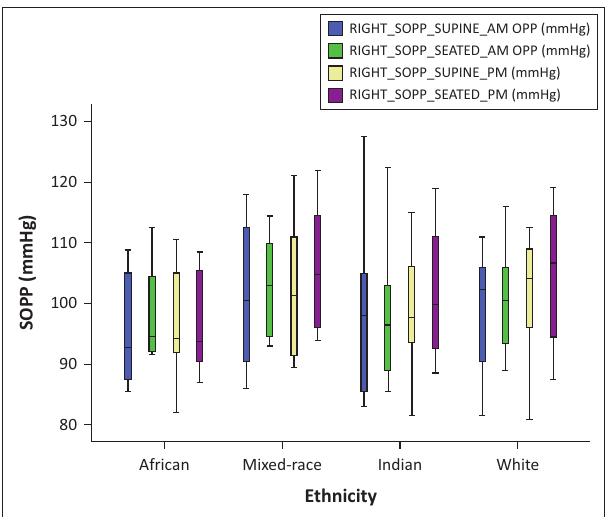
FIGURE 1: Box plot for systolic ocular perfusion pressure and different ethnicities in the seated and supine position in the morning and